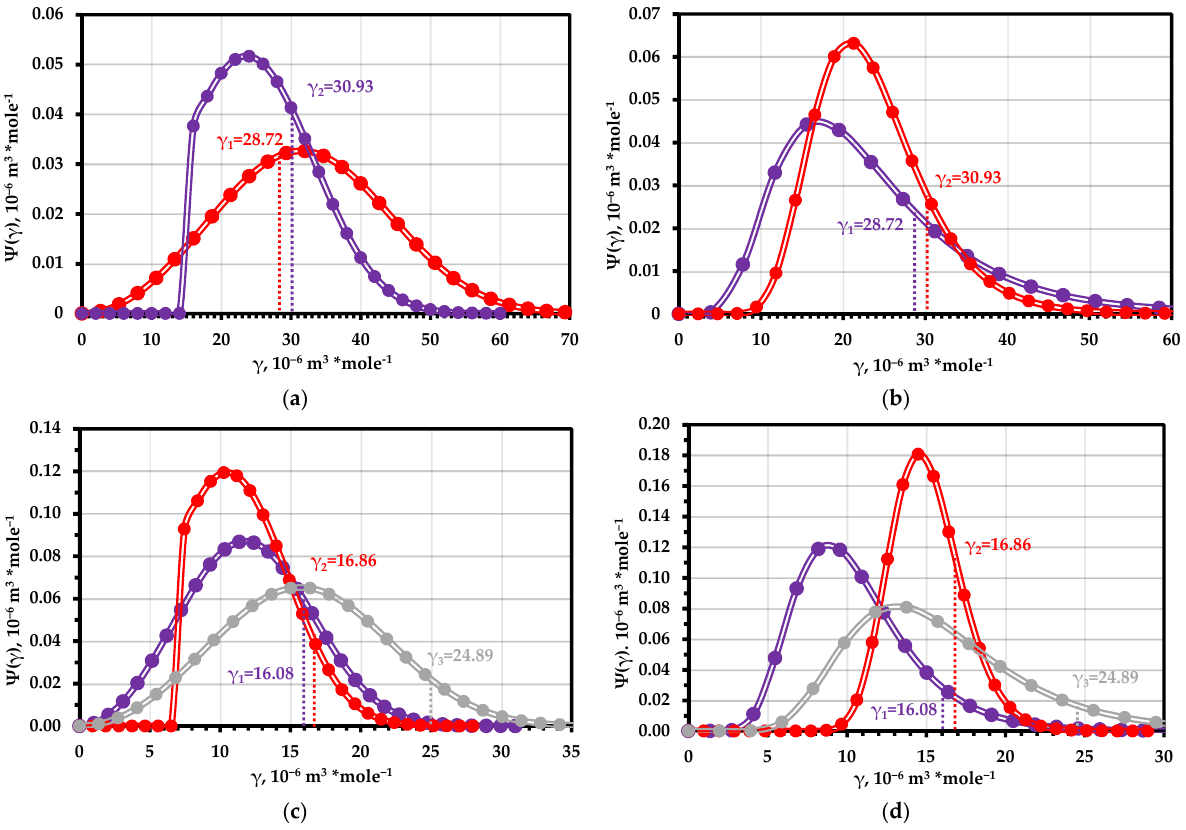
Figure 8. The distribution of the structural parameter γ during homogeneous fracture: ( a )—Weibull distribution for D2 steel samples (red—C2 sample; blue—E3 sample); ( b )—logarithmically normal distribution for D2 steel samples (red—E3 sample; blue—C2 sample); ( c )—Weibull distribution for M520 steel samples; ( d )—logarithmically normal distribution for M520 steel samples (blue–inherent defect, red—weld seam without defect, and gray—weld seam with defect).